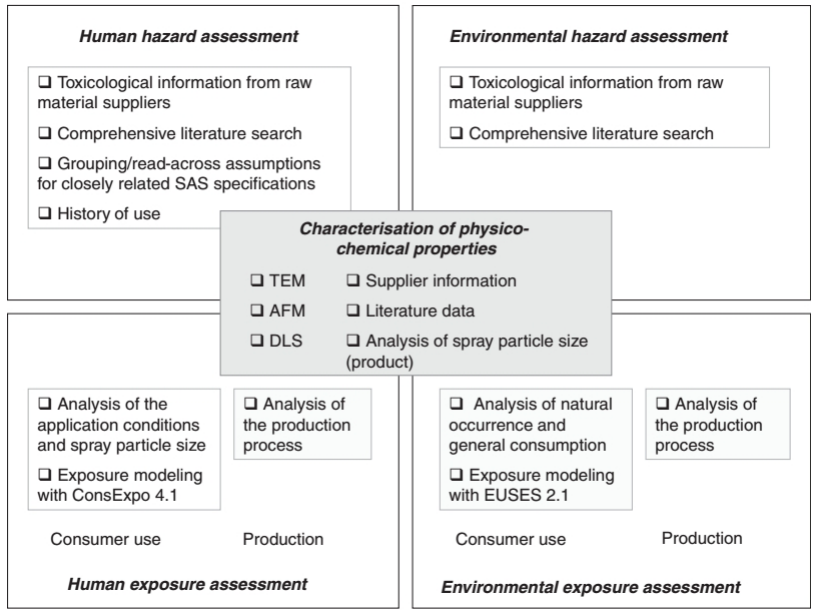
Fig. 10. A conceptual model of methodology and structural blocks in